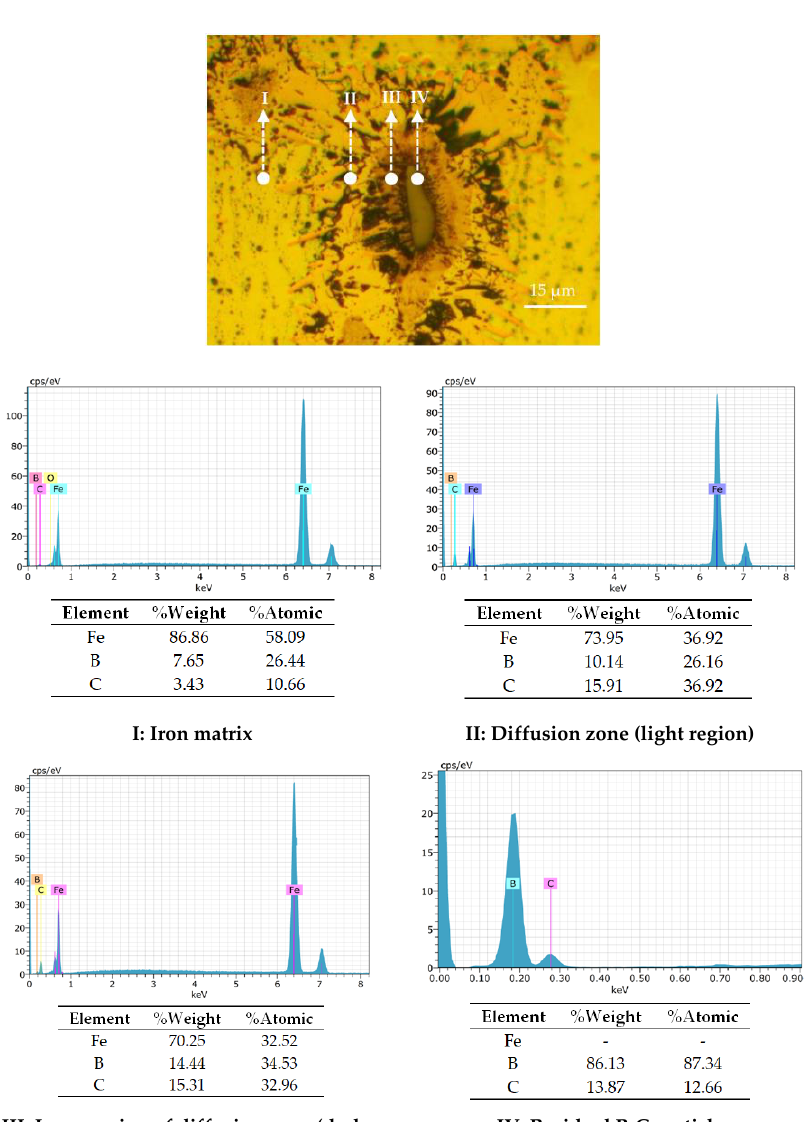
Figure 6. Energy-dispersive X-ray spectroscopy (EDS) analyses for the Fe + 10 vol.% B 4 C (60 min sintered) composite throughout the iron matrix (I) and different points of the diffusion zone (II–IV).